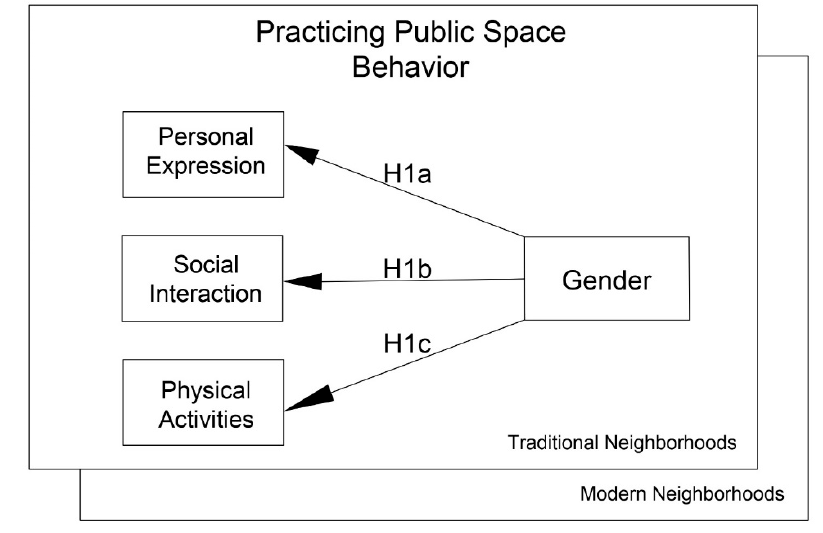
Figure 4. Model 1 for the first three hypotheses.